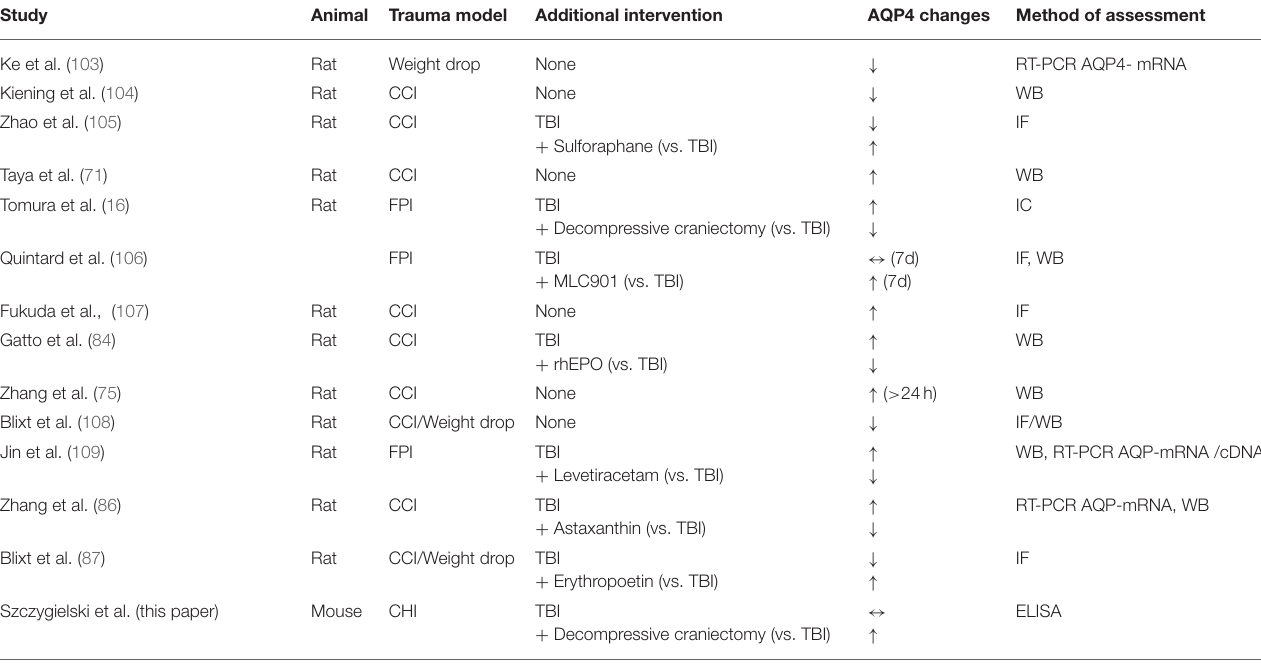
TABLE 1 | Summary of reported AQP4-related changes in different animal models of TBI.